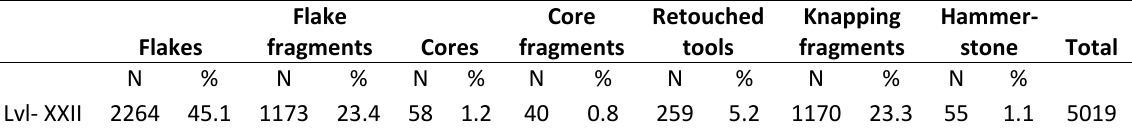
Core Retouched Knapping Hammer- fragments tools fragments stone Total